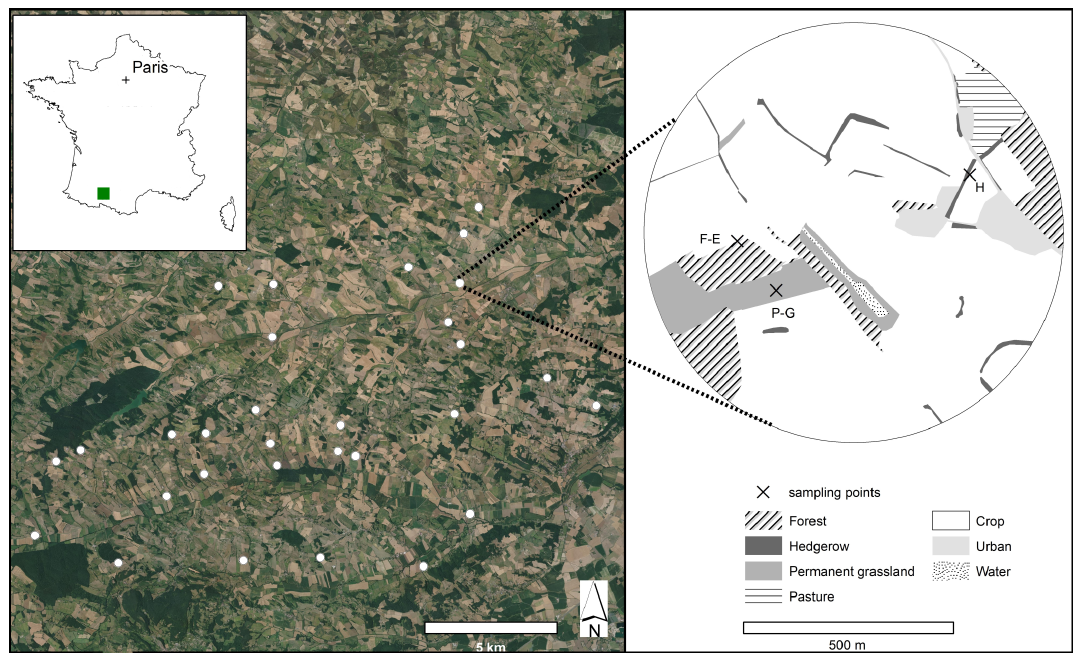
Figure 1. Maps showing the study area with on the left the 30 landscapes sampled, and on the right the location of the three sampling points in one of the 30 landscapes. P-G: permanent grassland, H: hedgerow and F-E: forest edge. BD ORTHO R (cid:13) 20